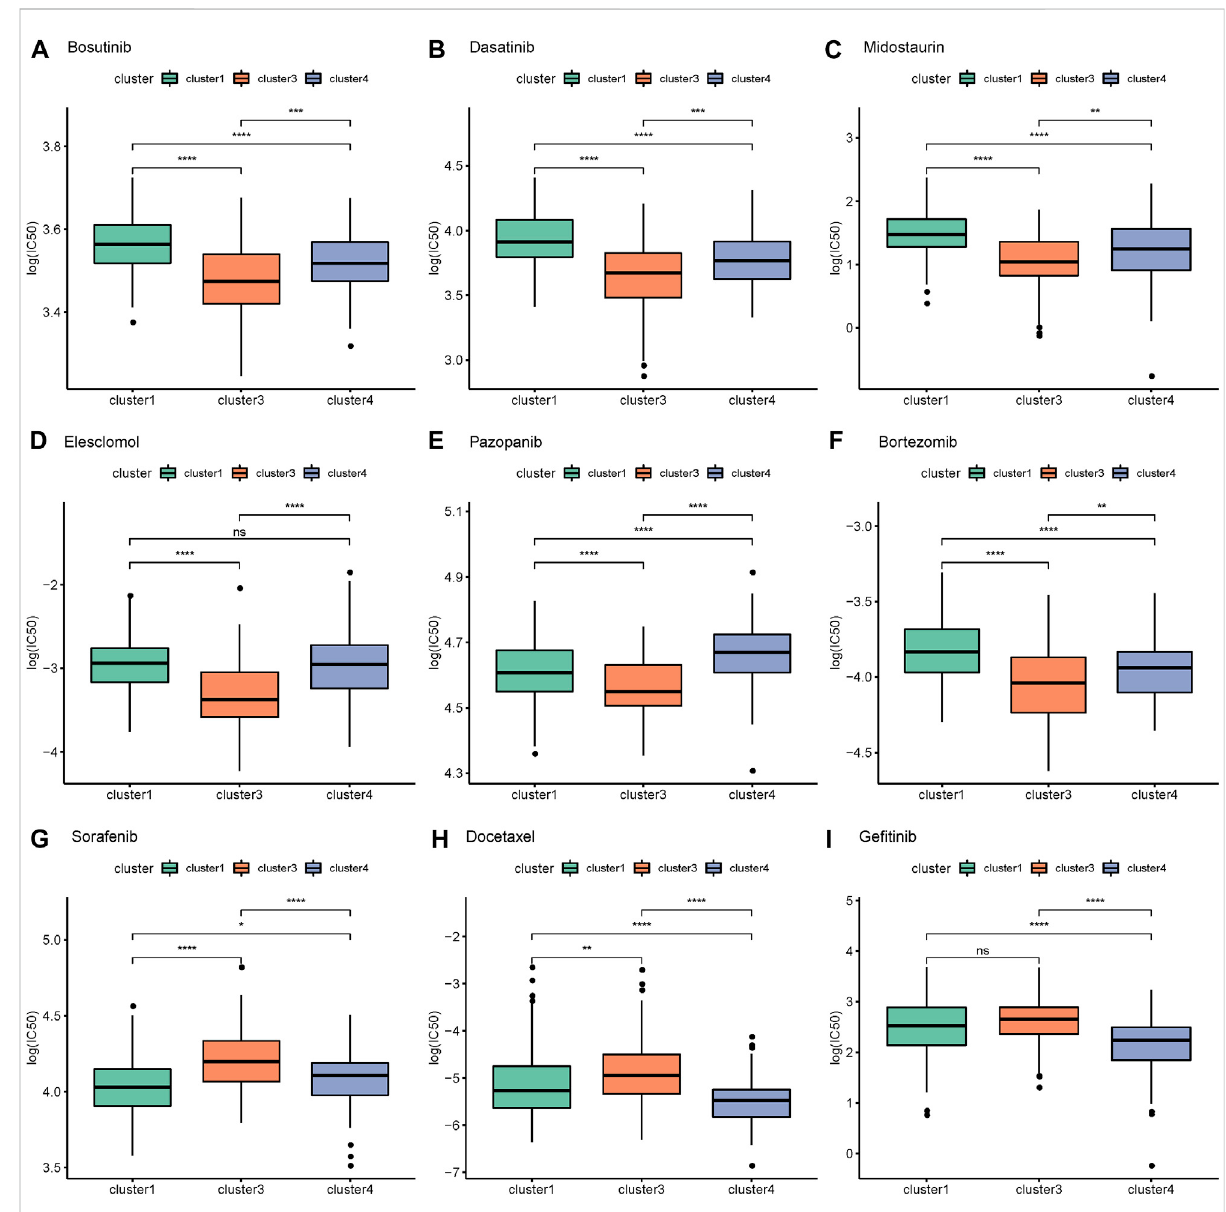
FIGURE 6 Response of alternative splicing subtypes to drugs. (A) Bosutinib (B) Dasatinib (C) Midostaurin (D) Elesclomol (E) Pazopanib (F) Bortezomib (G) Sorafenib (H) Docetaxel (I) Ge fi